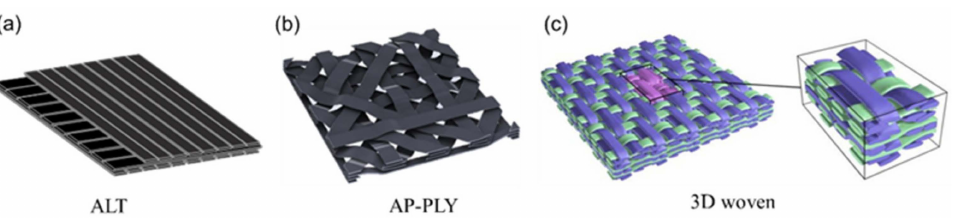
Figure 11. Schematics of mesoscale structure of composites manufacturing using ( a ) ALT, ( b ) AP-PLY (clutch laminate) [164] and ( c ) 3D woven